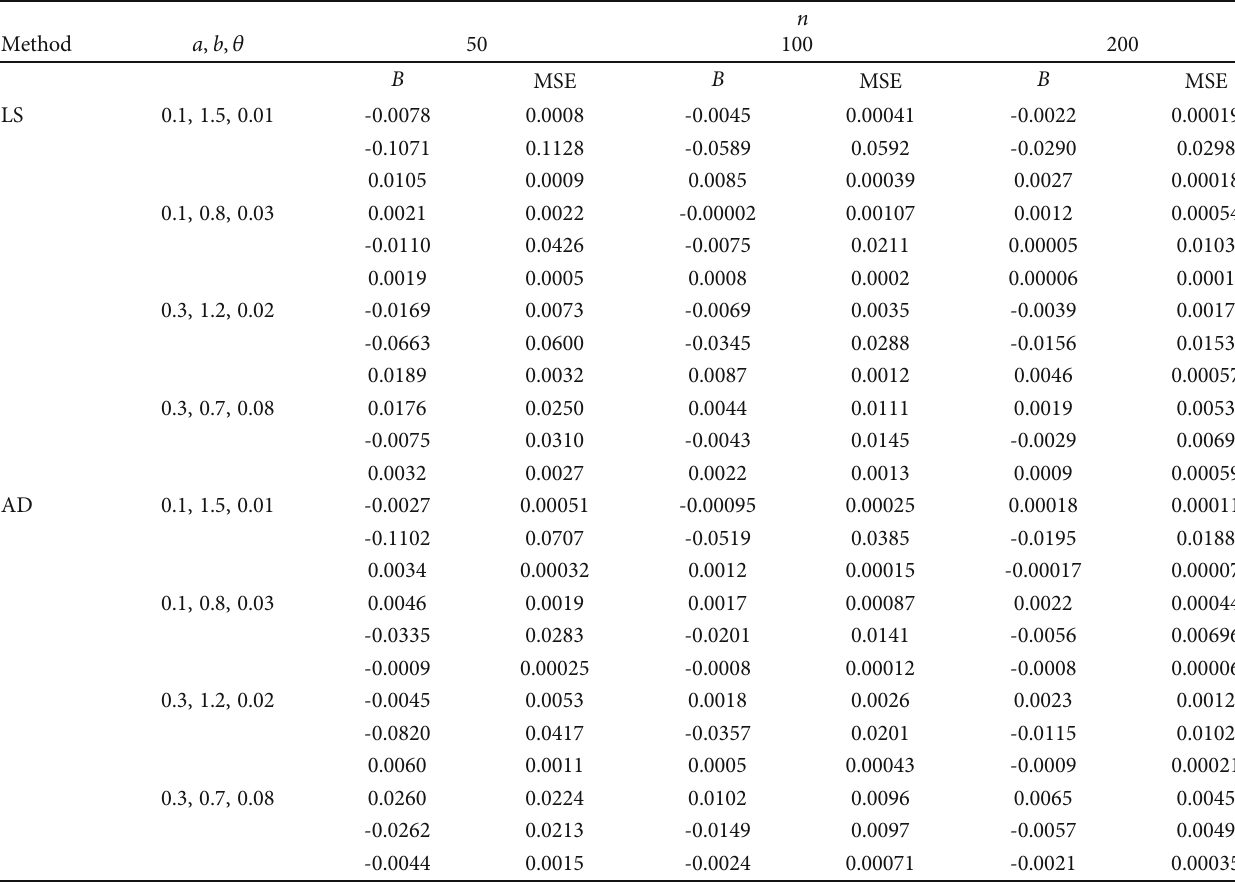
Table 2: The bias and MSE of the LS and AD estimators computed by a simulation study. Each cell consists of B and MSE in the second row, and B θ and MSE θ in the third B b b